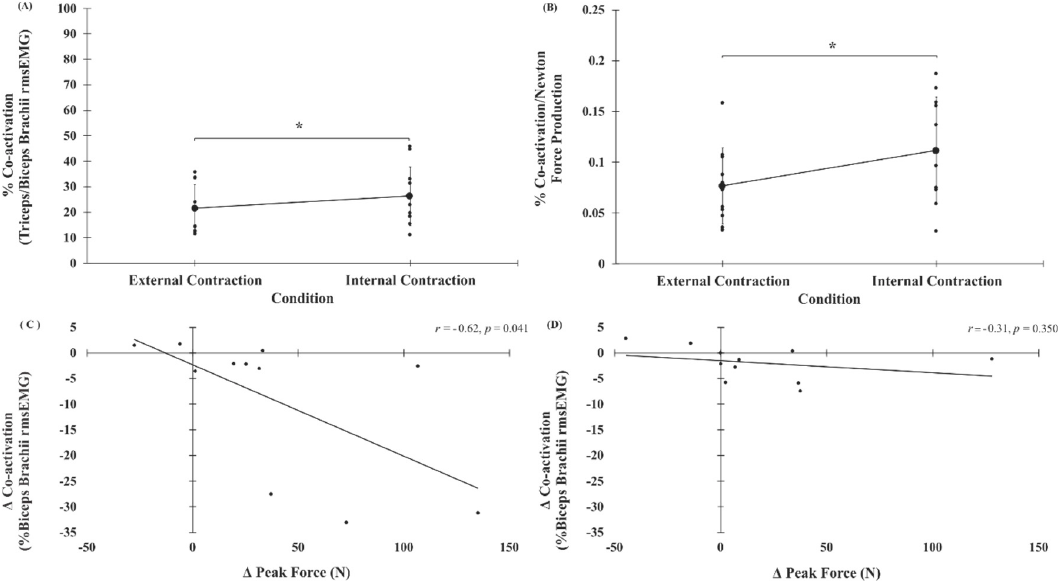
Figure 5. Data expressing the relationship between muscle co-activation and MVC peak force. In panels A–B, smaller points represent individual participant data, larger points represent mean, and error bars represent one standard deviation. In panels D–E, points represent individual data. ( A ) Muscle co-activation values for external and internal conditions, collapsed across trials (trial 1 to trial 6) and sessions (no-stimulation, stimulation), demonstrating the significant main effect of CONDITION. ( B ) Percentage of muscle co-activation/MVC peak force (co-activation per Newton ( B ) Percentage of muscle co-activation / MVC peak force (co-activation per Newton force production) for external versus internal conditions, collapsed across session (no-stimulation, stimulation), illustrating changes in MVC peak force and triceps brachii / biceps brachii co-activation across external and